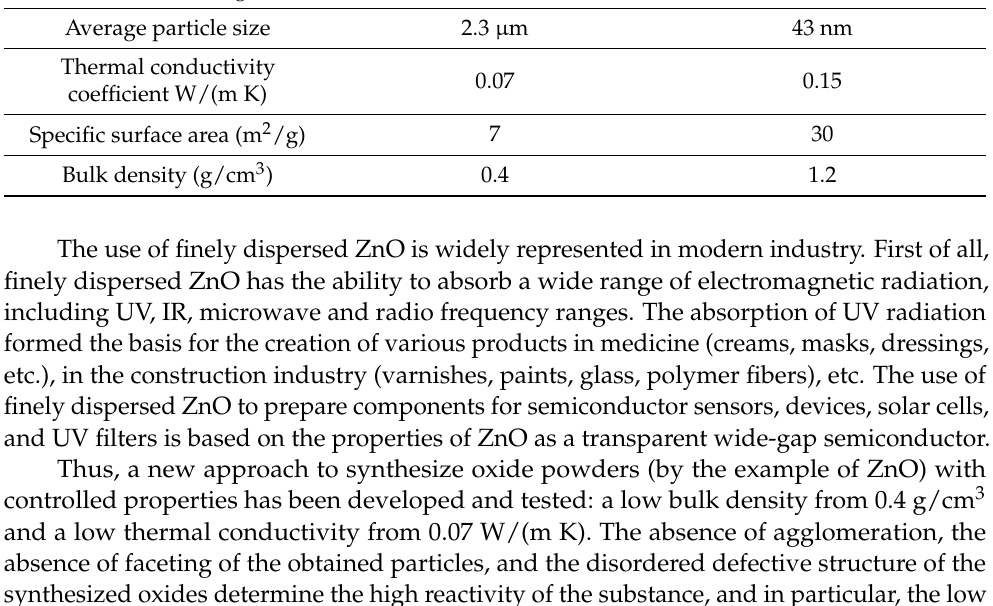
Table 1. Analysis of the content of C, H, N (wt%) depending on the processing temperature of the